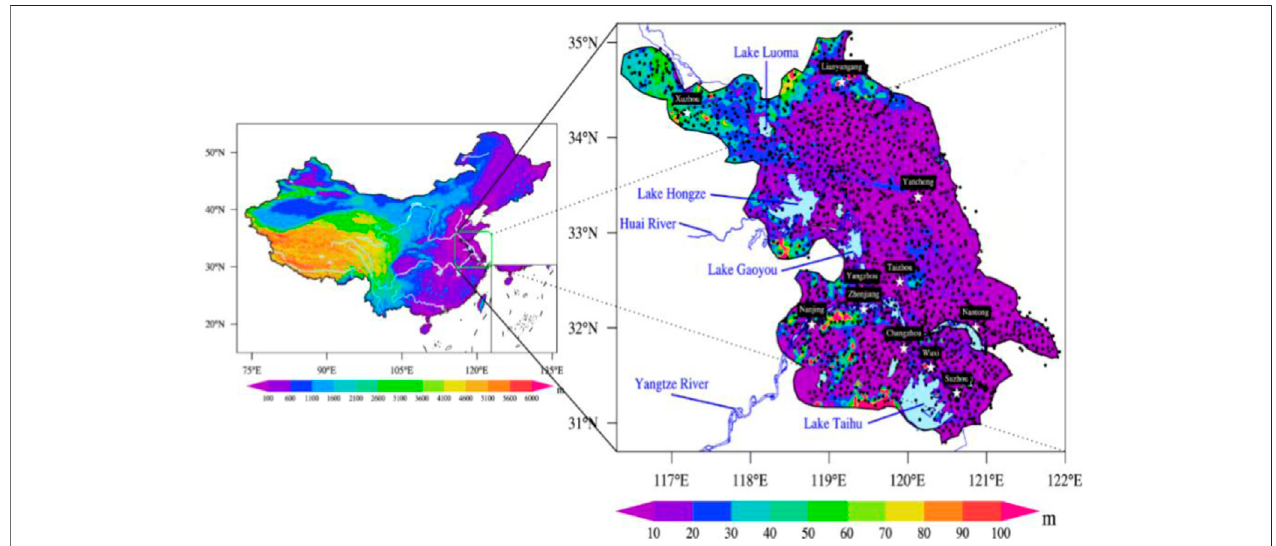
FIGURE 1 | The surface elevation (shaded) and rain gauges locations (dots) in Jiangsu. The left fi gure is the map of China and the location of study area. The right fi gure is a detailed map of Jiangsu Province.